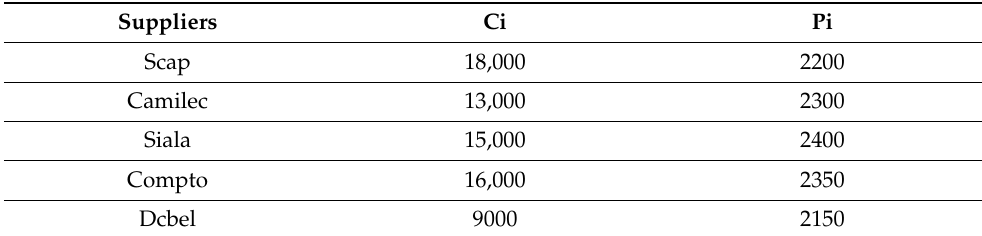
Table 8. Capacity with the Purchasing Price